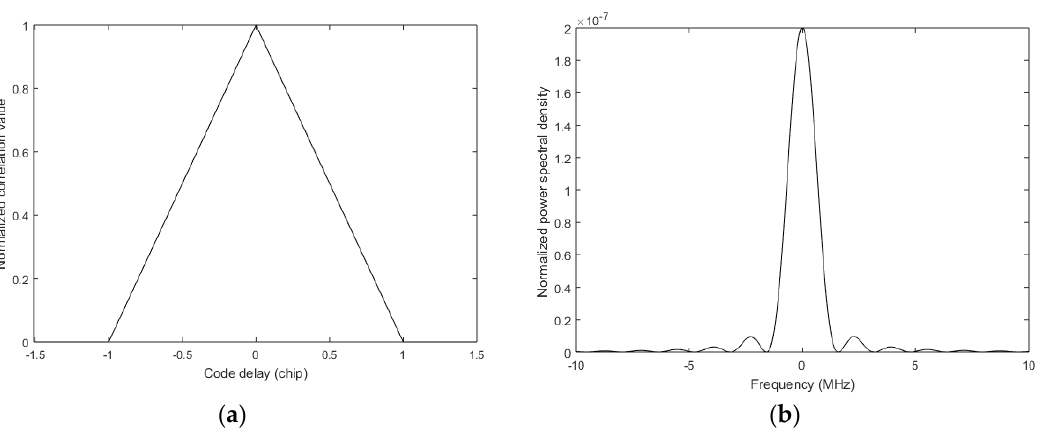
Figure 4. Characteristics of the autocorrelation function: ( a ) is autocorrelation function with infinite bandwidth; and ( b ) is power spectral density.